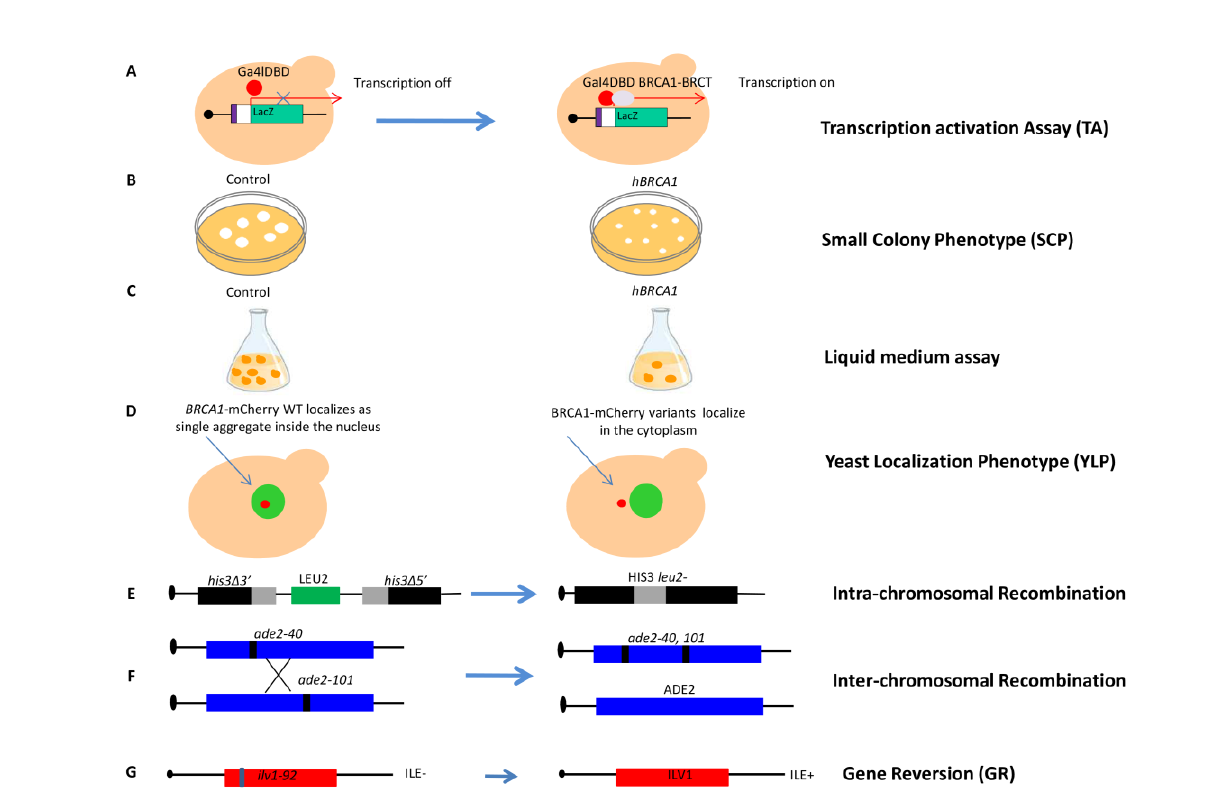
FIGURE 4: Schematic representation of the yeast functional assays for BRCA1/2 (A) Transcription activation assay (TA) : The BRCT domain of BRCA1 is cloned in frame with the GAL4 or LexA DNA binding domain (DBD). WT BRCT fused to DBD is able to activate transcription of the reporter gene LacZ under control of the minimal promoter (white) containing the binding sequences (violet) recognized by the GAL4 or LexA DBD. Variants affecting BRCT domain activity are not able to activate LacZ transcription. (B) Small colony phenotype assay (SCP) : yeast cells expressing BRCA1 (from pADH1 fused to the activation domain of GAL4, or from inducible pGAL1) form colonies considerably smaller than controls after incubation at 30°C. Yeast colonies re resuspended in water, and the number of cells per colony are determined by counting. Small colonies correlate with slow growth, there- fore the inhibition of growth determined by BRCA1 expression can be performed also in liquid medium. (C) Liquid Medium assay : this assay monitors the growth defect of yeast cells expressing BRCA1 as in the SCP, but in liquid instead of solid medium. (D) Yeast localization phenotype assay (YLP) : this assay is performed in yeast cells expressing BRCA1 cloned in frame with m-Cherry at C-terminus ( BRCA1 -mCherry) under control of the inducible GAL promoter. Yeast cells expressing WT or BRCA1 variants fused to mCherry are induced for 4 h with galactose before live fluorescent microscopy analyses. The nucleus is identified by the expression of the nuclear protein Nup133 fused to GFP (Nup133-GFP, green). Whereas the WT BRCA1 pro- tein shows mainly nuclear localization (Red spot), pathogenic variants show prevalent cytoplasmic localization. (E) Intra- chromosomal recombina- tion : the yeast strain carries the two his3 alleles separated by the LEU2 marker and by the plasmi d DNA sequence, one with a deletion at the 3’ end and the other with a deletion at the 5’ end, which share 400 bp of homology (gray box). An intra -chromosomal recombination event leads to HIS3 reversion and loss of LEU2 determined by counting colonies grown in medium lacking histidine (HIS3+). (F) Inter-chromosomal recombination : the yeast strain contains the two alleles ade2-40 and ade2-101 , located in two homologous chromosomes. An inter-chromosomal recombination event leads to WT ADE2 determined directly by counting colonies grown in medium lacking adenine (ADE2+). (G) Gene reversion (GR) : the yeast strain carries the ilv1-92 that allows the assessment of gene reversion to ILV1 by direct counting colonies grown in medium lacking isoleucine